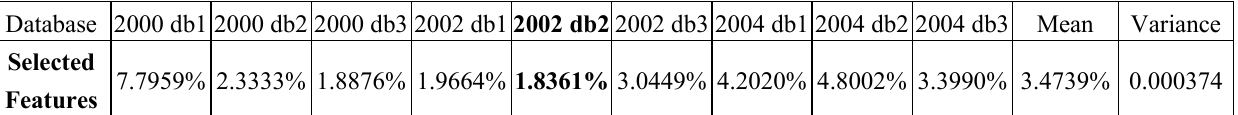
Table 6. Segmentation error rates in homogenous and heterogeneous